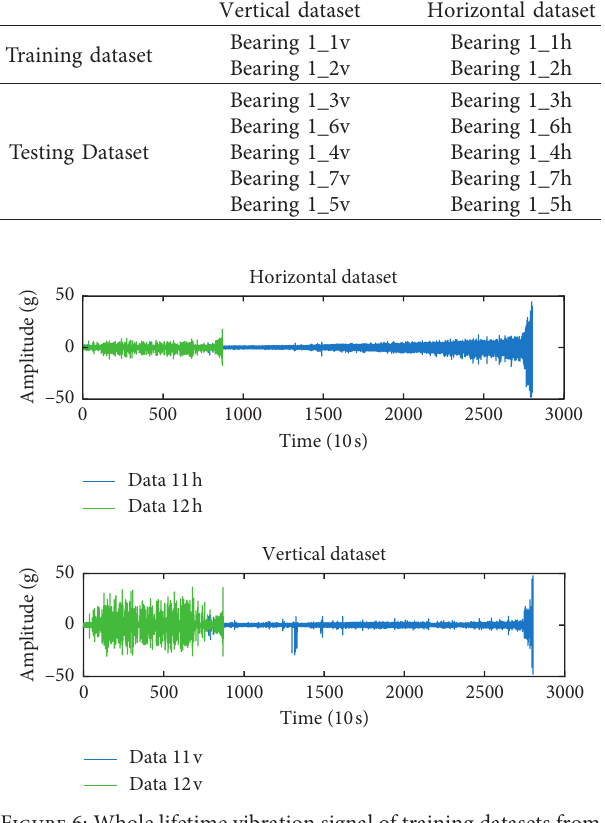
Figure 6: Whole lifetime vibration signal of training datasets from 2